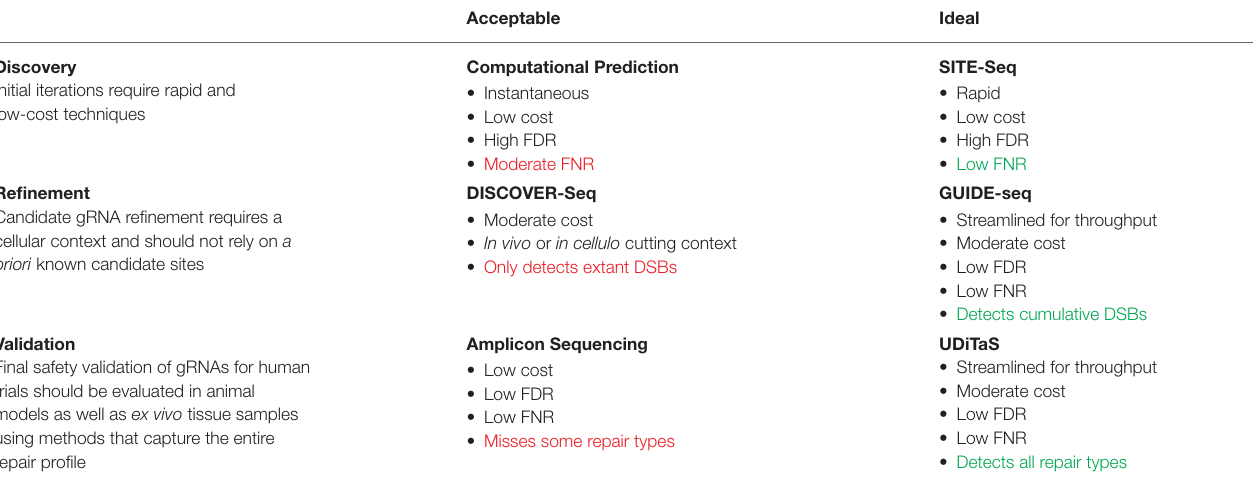
TABLE 3 | Criteria for choosing the appropriate off-target detection method for each stage of gRNA